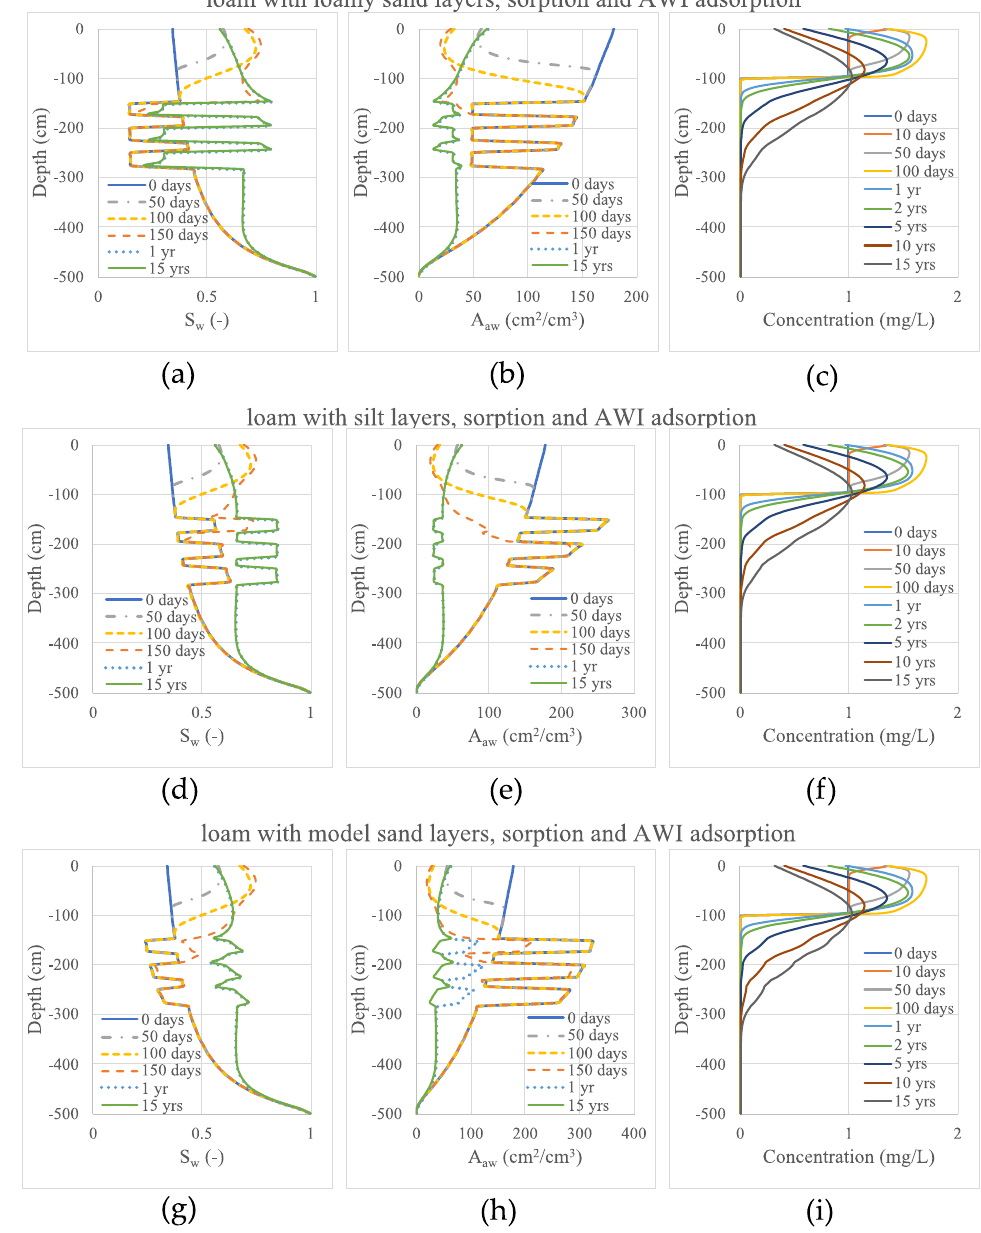
Figure 10. Simulated results of PFOS unsaturated transport within a layered heterogeneous vadose zone (loamy sand, silt, and model sand layers in a loam vadose zone): ( a ) change in S w with depth for the loamy sand layered system; ( b ) change in A aw with depth for the loamy sand layered system; ( c ) PFOS transport within the loamy sand layered system; ( d ) change in S w with depth for the silt layered system; ( e ) change in A aw with depth for the silt layered system; ( f ) PFOS transport within the silt layered system; ( g ) change in S w with depth for the model sand layered system; ( h ) change in A aw with depth for the model sand layered system; ( i ) PFOS transport within the model sand layered system.